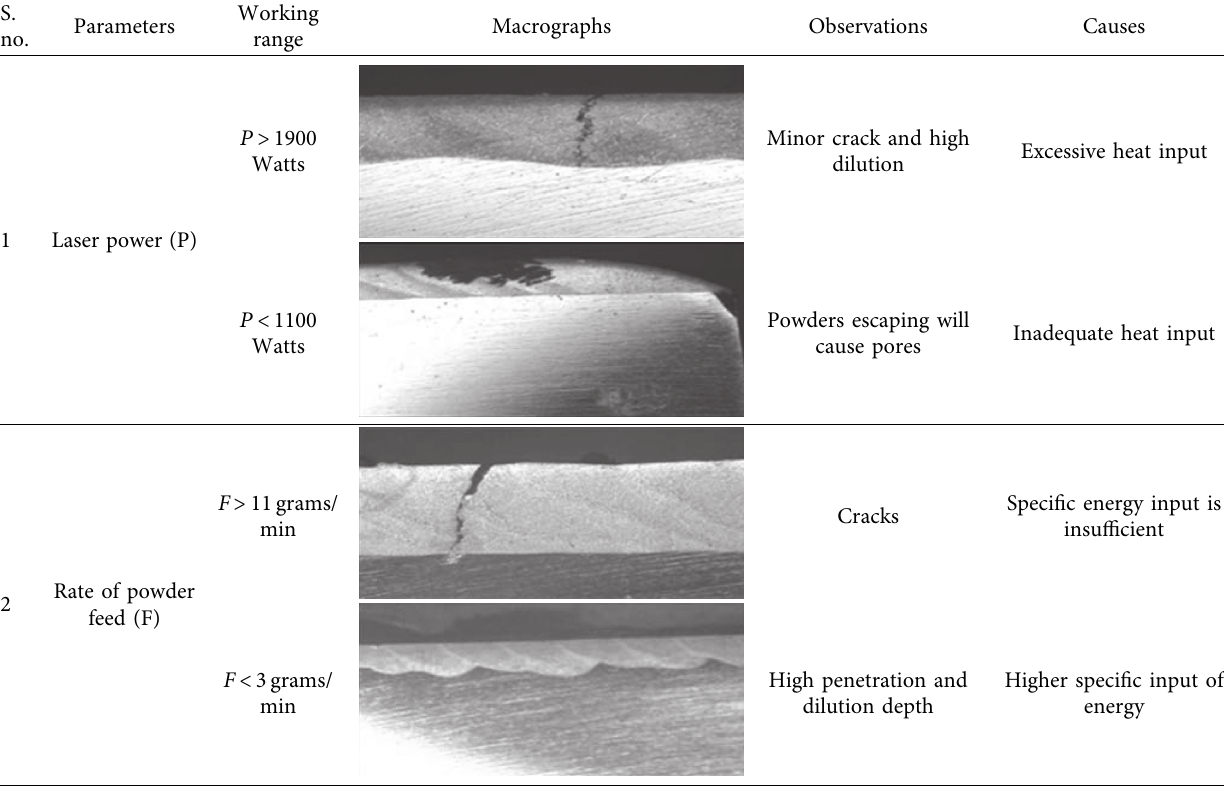
Table 4: Macrostructure investigation to determine the laser hardfacing’s operating